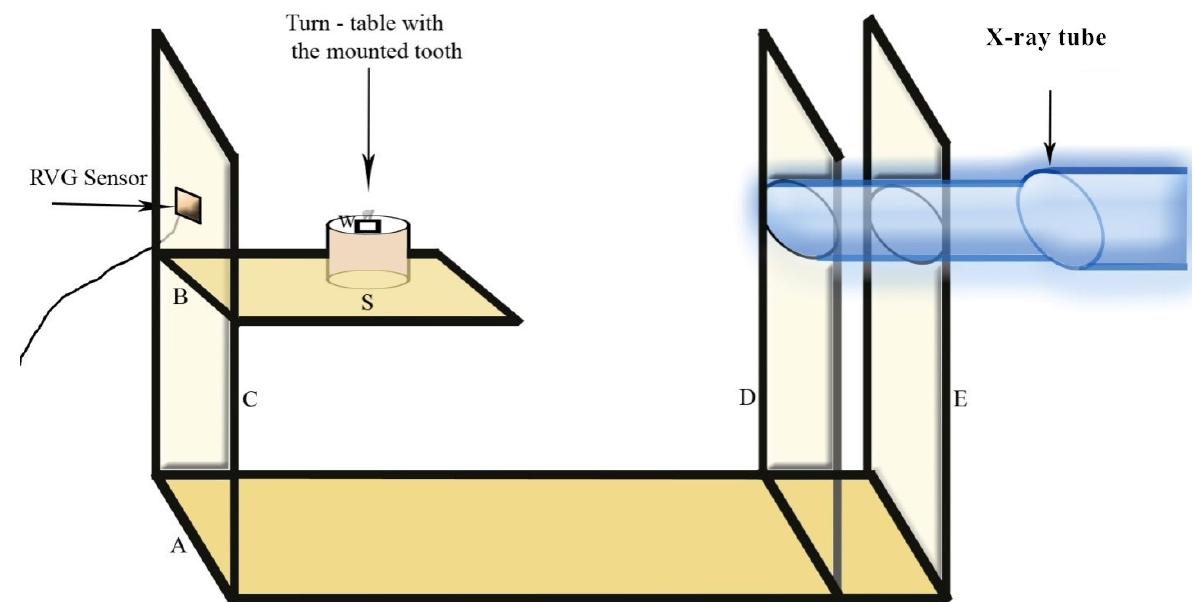
Figure 1. Diagrammatic presentation of plywood jig.